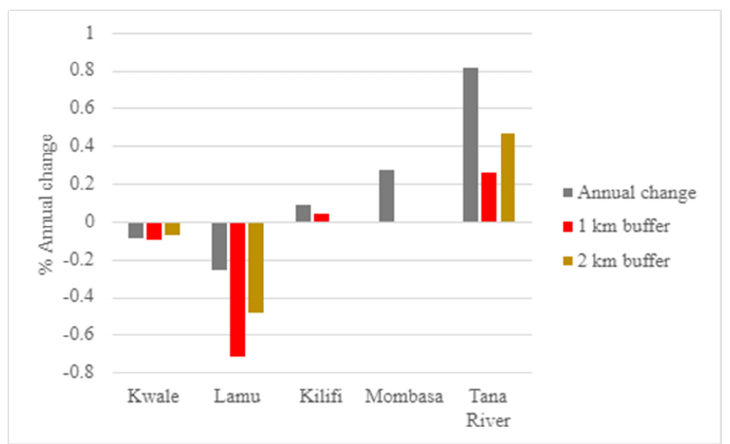
Figure 5. Average annual change of mangrove cover in Kenya’s coastal counties (%) and rates of change within 1 km and 2 km buffer zones around shoreline points at high and very high exposure (with all habitats scenario).